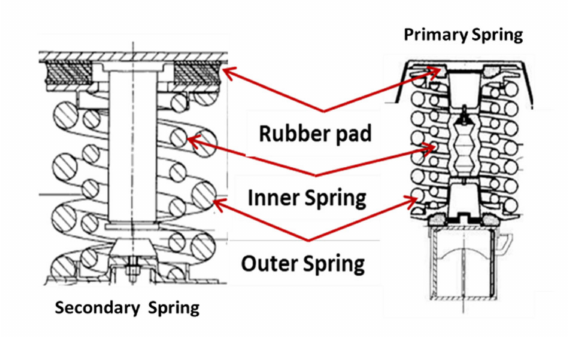
Figure 2. A cross-sectional view of the secondary spring and the primary